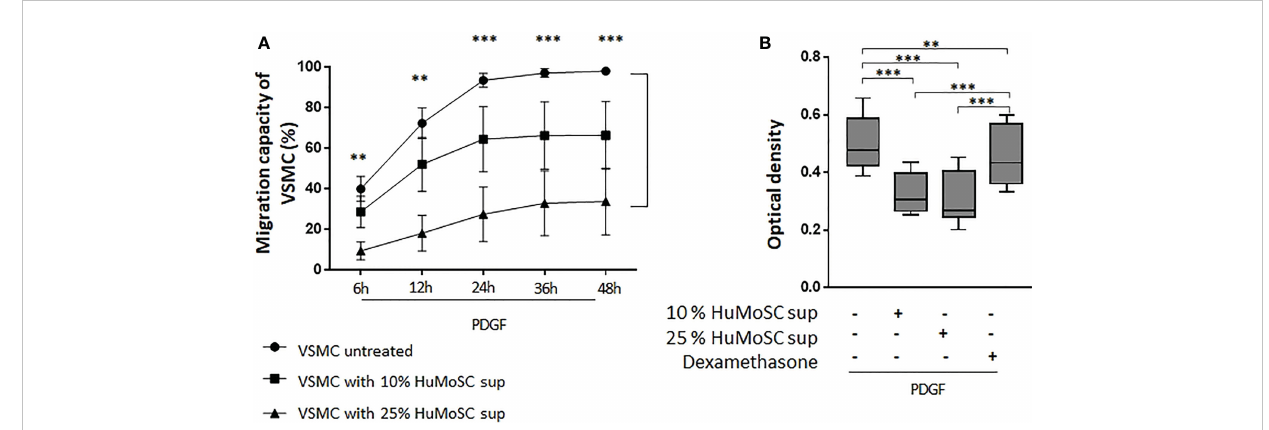
FIGURE 3 Effect of HuMoSC on migration and proliferation of VSMC. (A) Study of the migration of VSMC in the presence of PDGF-AB (20 ng/mL). Scratch assays were used to measure VSMC migration capacity. Time-lapse video microscopy recorded images during 48h. HuMoSC supernatant treatment was used at 10% or 25% in VSMC cultures. Data are presented as mean percentage of wound healing ± SEM (n=3 independent experiments). (B) Proliferation of VSMC was measured by optical density after treatment with crystal violet after 7 days of culture. VSMC were cultured with PDGF (20 ng/ml), dexamethasone (0,5 m g/ml) and/or 10% or 25% of supernatant of HuMoSC. Whisker boxes show the median (horizontal bar), the IQR (limits of the box) and extreme values (error bars). Results show triplicates from 4 independent experiments. P is the result of Mann Whitney